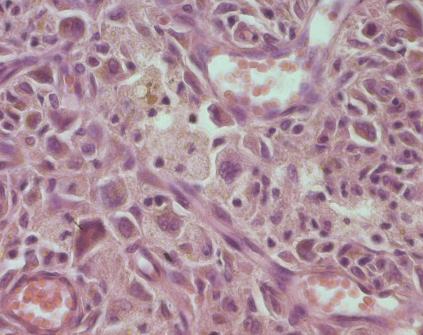
Figure 3: Histiocyte-like and fibroblast-like spindle cells inter- mingled with atypical mononuclear and giant cells, sometimes with foamy cytoplasm, showing nuclear pleomorphism and bizarre nuclei; a mitosis is seen in the upper right (hematoxylin and eosin × 100).